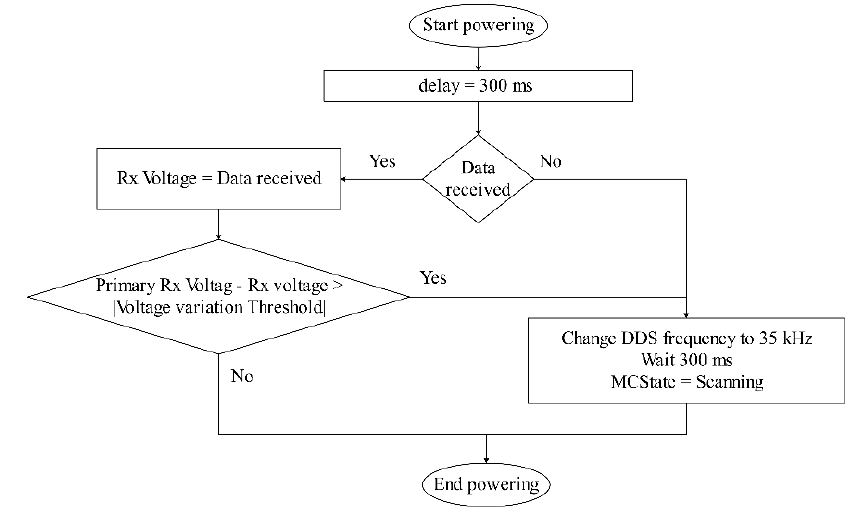
Figure 10. Powering phase algorithm flowchart.